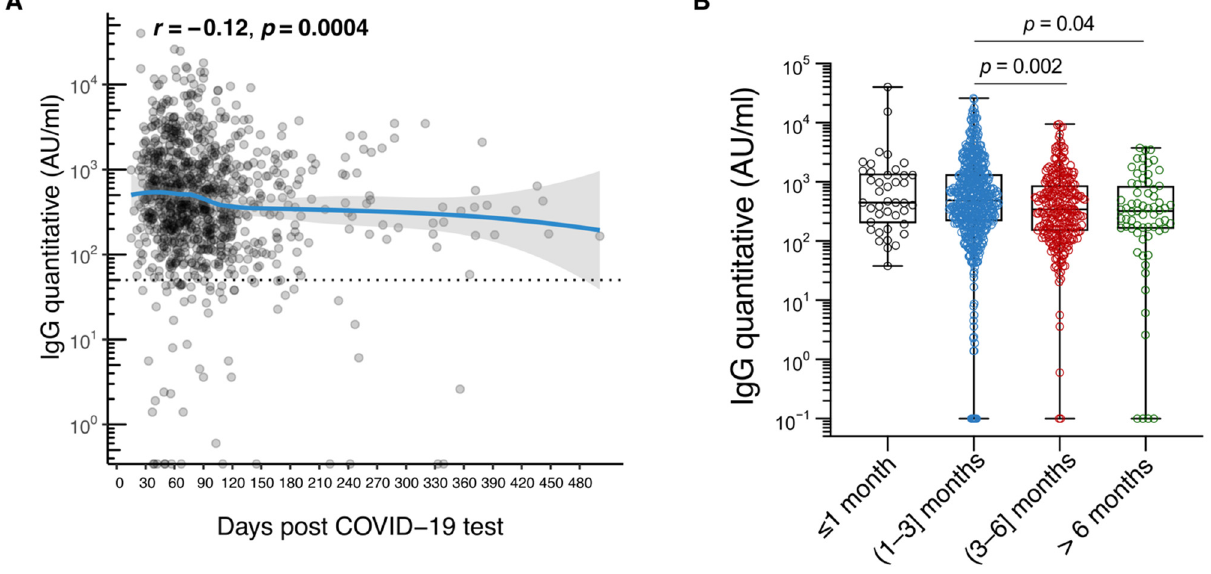
Figure 2. Immunoglobulin class G (IgG) antibody durability in the Cypriot population. ( A ). Plot of IgG levels in arbitrary units (AU)/mL against days since SARS-CoV-2 diagnosis; ( B ). Box plot of IgG levels in AU/mL ≤ 1 month, (1–3) months, (3–6) months, and >6 months post symptom onset. The analysis involved 969 unvaccinated people with a self-reported history of laboratory-confirmed SARS-CoV-2 infection.